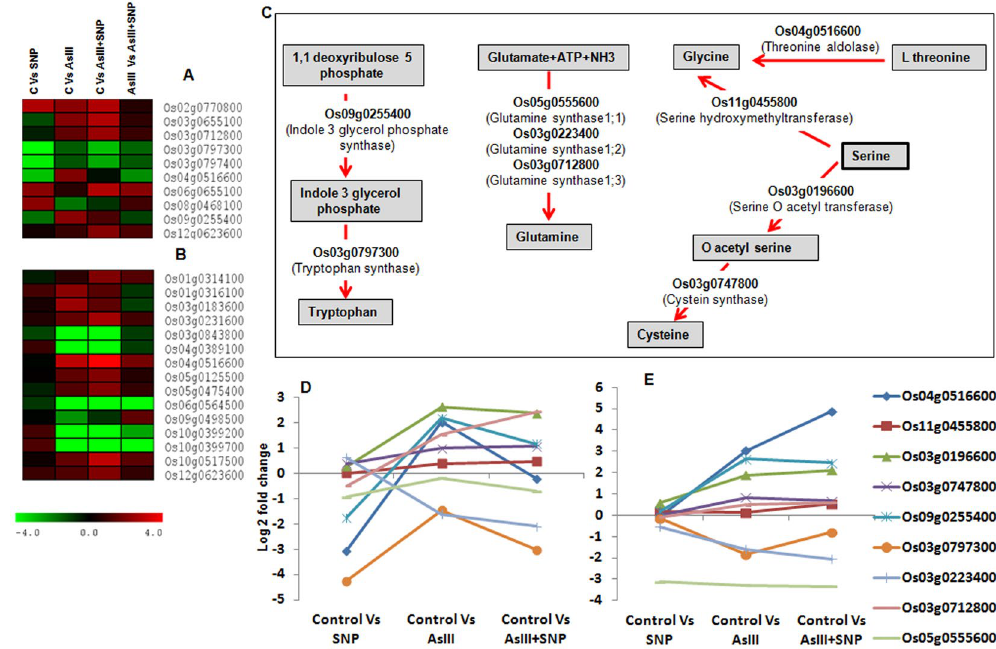
Figure 6. Differential expression analysis of amino acid and nitrogen metabolism related genes. ( A , B ) amino acid and nitrogen metabolism on 4 th and 12 th day respectively. ( C ) Modulation of the amino acid biosynthesis pathway (putative) and differential expressions of their candidate genes on 4 th day ( D ) and 12 th day ( E ). The modulation of amino acid and nitrogen metabolism gene in the AsIII and AsIII + SNP treatment suggested that NO might be involved in maintaining nitrogen metabolism during AsIII